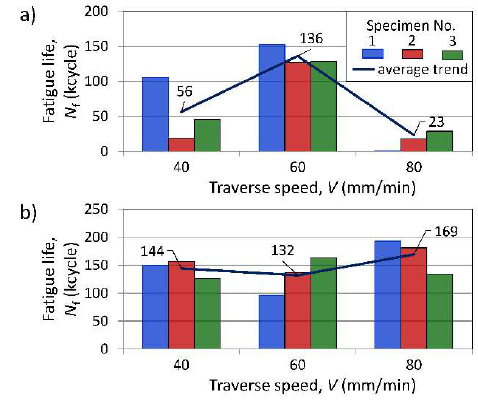
Figure 16. Influence of traverse welding speed on fatigue life of FSW joint specimens ( R = 0, S = 160 MPa): ( a ) orientation L; ( b ) orientation